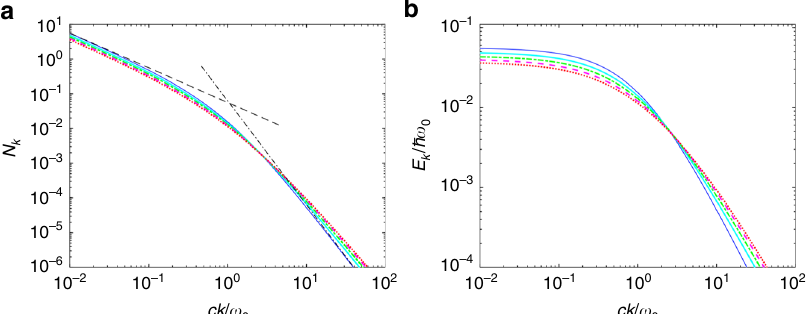
Fig. 3 Virtual photons in the detuned Lorentz model. a Number of virtual photons in the ground state as a function of the photonic wavevector for ω c = 0.5 ω 0 and different values of the losses. The black dashed and dash-dotted lines are the small and large k expansions. b Photonic energy per mode E k ¼ (cid:1) hckN k as a function of the photonic wavevector for ω cyan line), ω 0 (dash-dotted green line), 1.5 ω 0 (dashed magenta line) and 2 ω 0 (dotted red